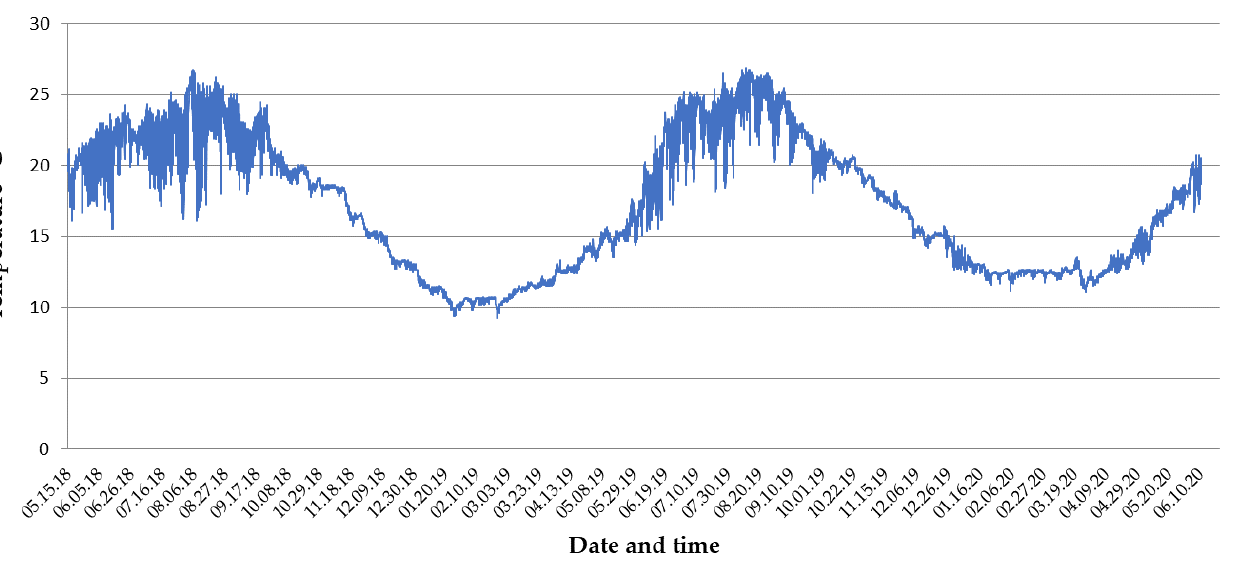
Figure 10. Collector bag from 2 m depth in Luka Cove completely covered with invasive ascidian Styela plicata (Lesueur, 1823).